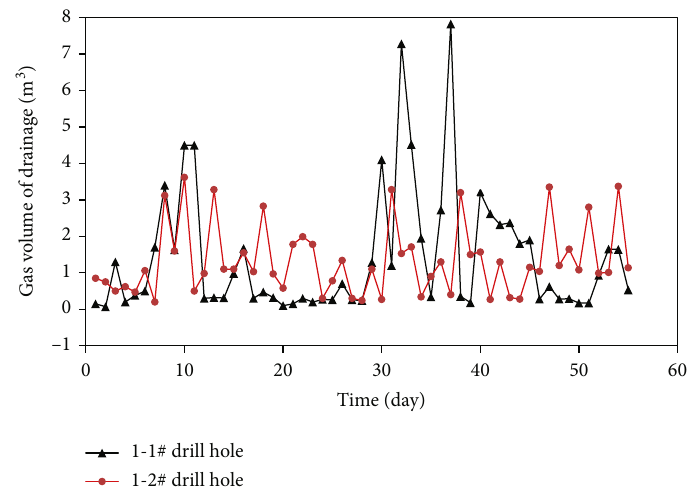
Figure 6: Gas extraction in the borehole group 1#.